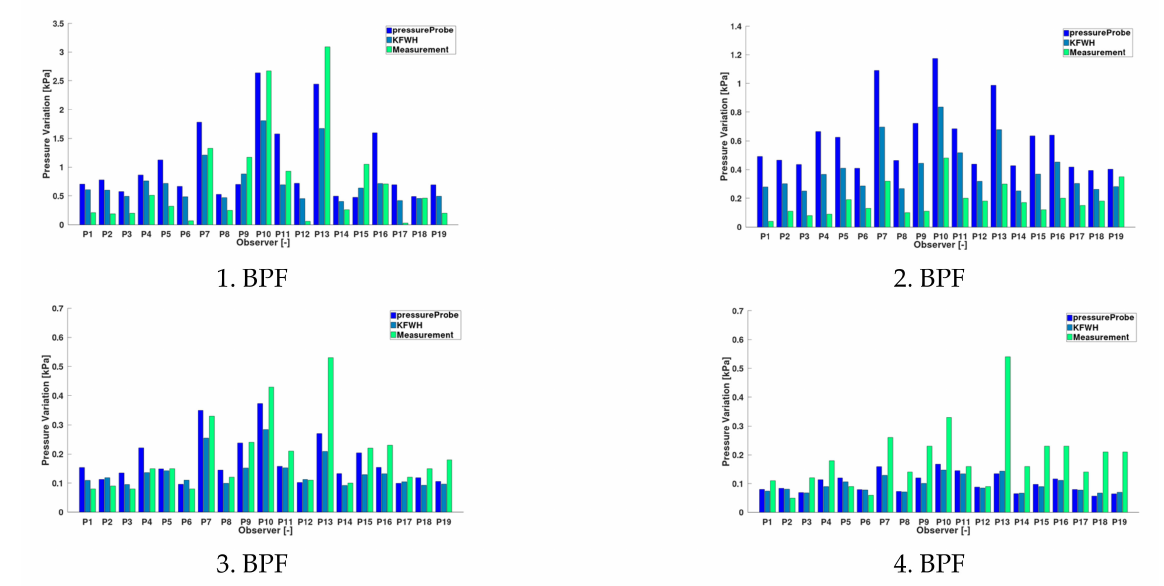
Figure 17. SCHOTTEL reference case 1. Pressure amplitudes obtained with the direct pressure and KFWH method at blade passing frequencies (BPF) in comparison to the experiment at full scale in propulsion condition with